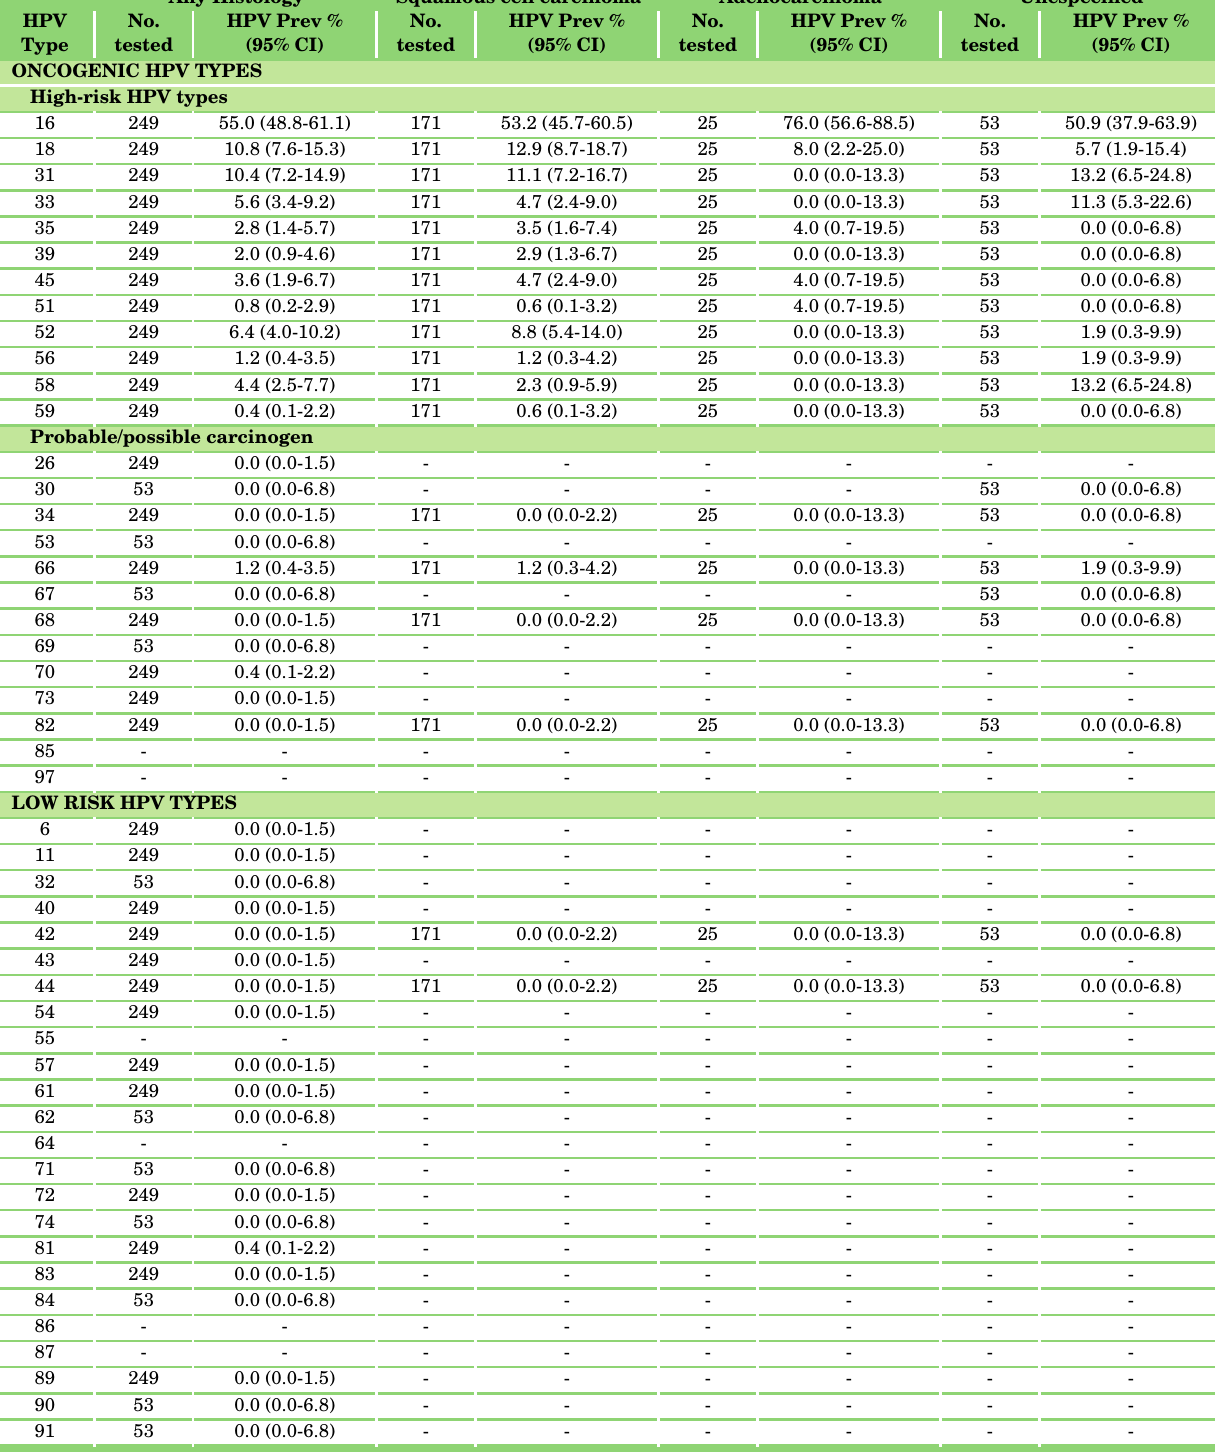
Table 23: Type-specific HPV prevalence among invasive cervical cancer cases in Peru by histology Any Histology Squamous cell carcinoma Adenocarcinoma Unespecified